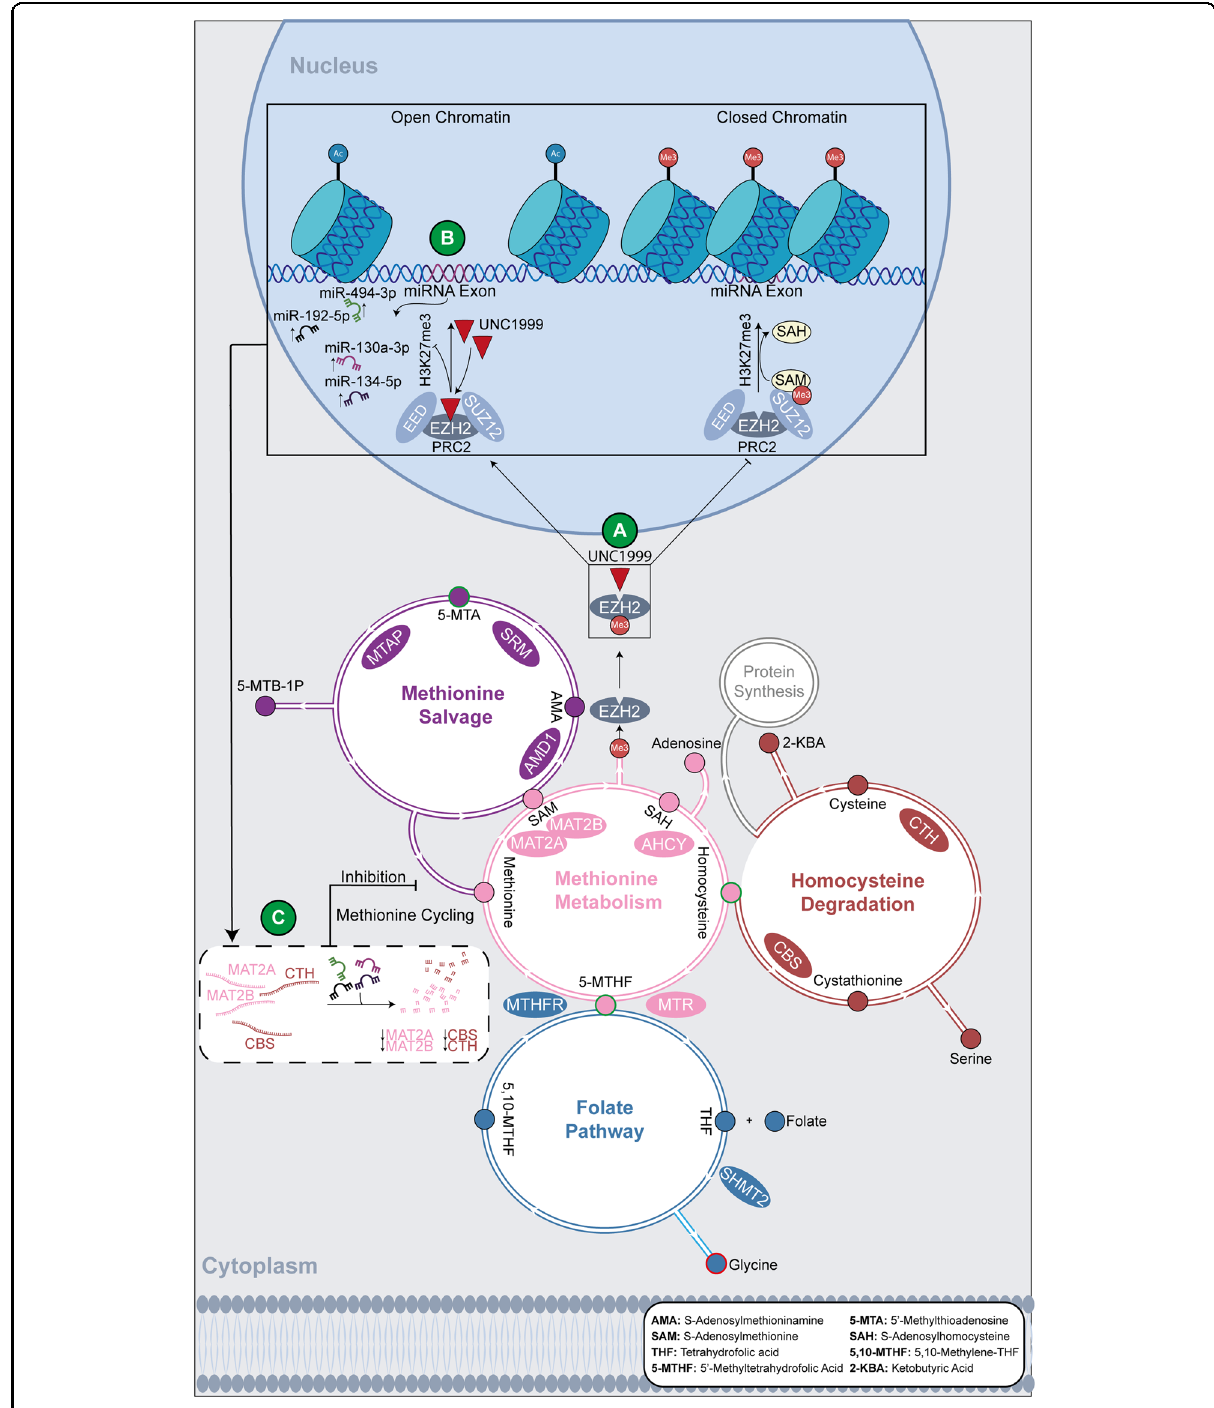
Fig. 6 Schematic representation of the downstream effects of EZH2i on the metabolic pro fi le of sensitive MM cell lines. A UNC1999 inhibits the activity of EZH2. B This prevents EZH2 from methylating H3, thus resulting in loss of H3K27me3 and open chromatin. As a consequence, the tumour-suppressor miRNAs miR-494-39, miR-192-5p, miR-130a-3p and miR-134-5p, which are silenced by H3K27me3 under basal conditions, are upregulated. C The tumour-suppressor miRNAs downregulate their target genes ( MAT2A , MAT2B , CBS and CTH ), which encode for enzymes involved in methionine cycling. This dysregulates methionine cycling and results in variation of metabolite abundance, such as accumulation of homocysteine. Metabolites in each pathway are indicated by small circles, which are colour coded with the same colour of the pathway they participate in. Metabolites that vary in abundance post UNC1999 treatment are marked by either a red (decreased abundance) or a green (accumulation) border.